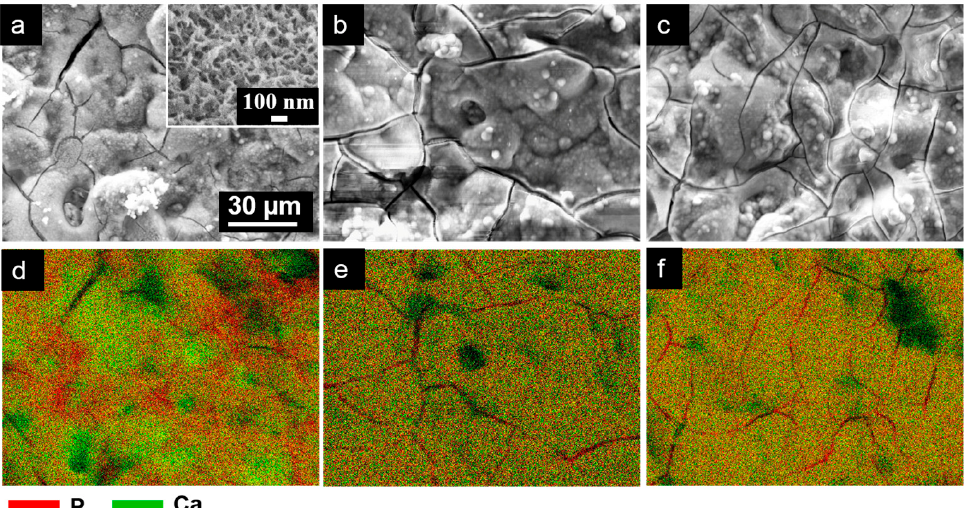
Figure 11. ( a – c ) Surface morphology and ( d – f ) EDX spectra for P and Ca of the apatite layer formed on the anodized surfaces of AM60, AM60-1Ca, and AM60-2Ca, respectively, after immersion in SBF for 14 days.